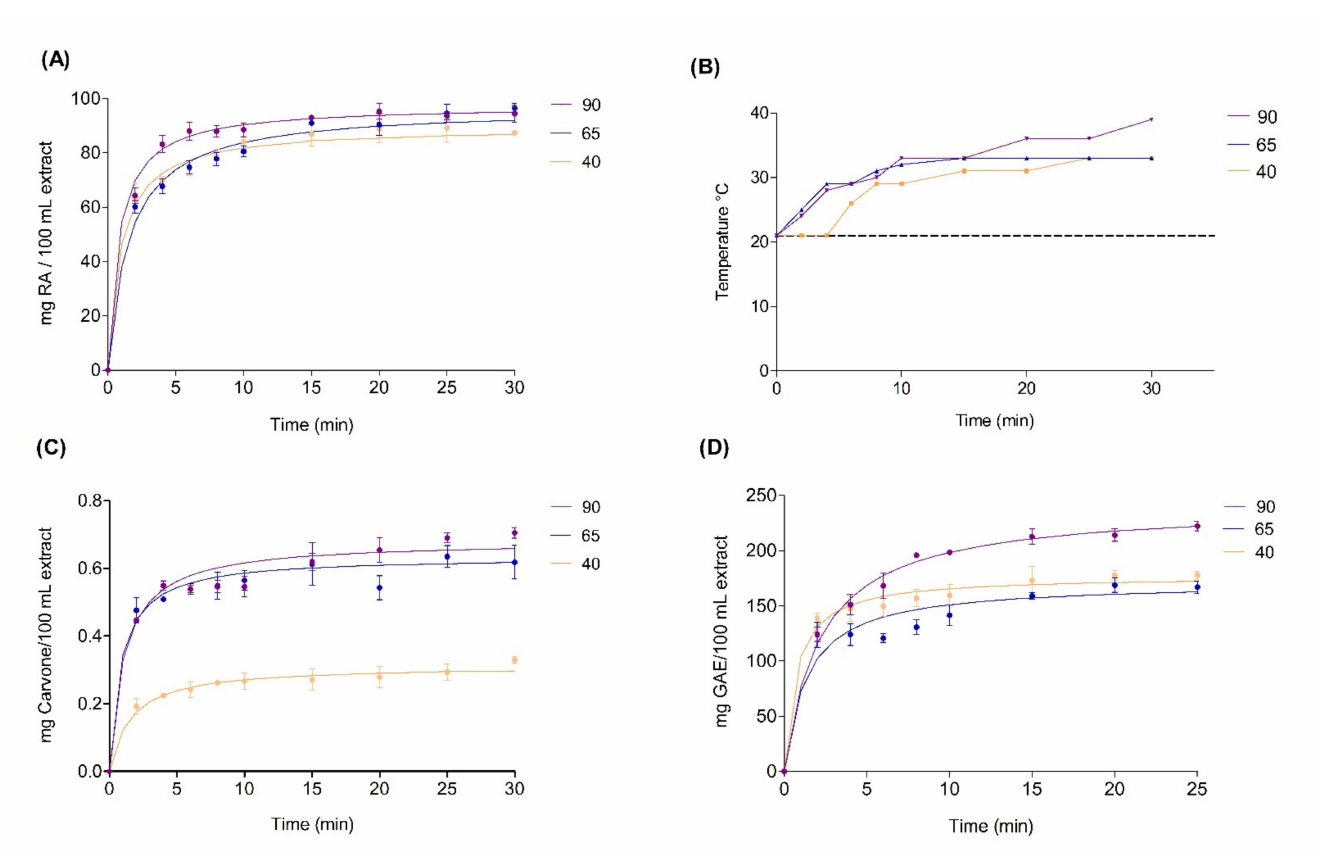
Figure 3. Kinetics extractions of total polyphenols (TPC) ( A ), temperature changes during the extraction at different temperatures ( B ), kinetics extractions of rosmarinic acid ( C ), and kinetics extractions of carvone ( D